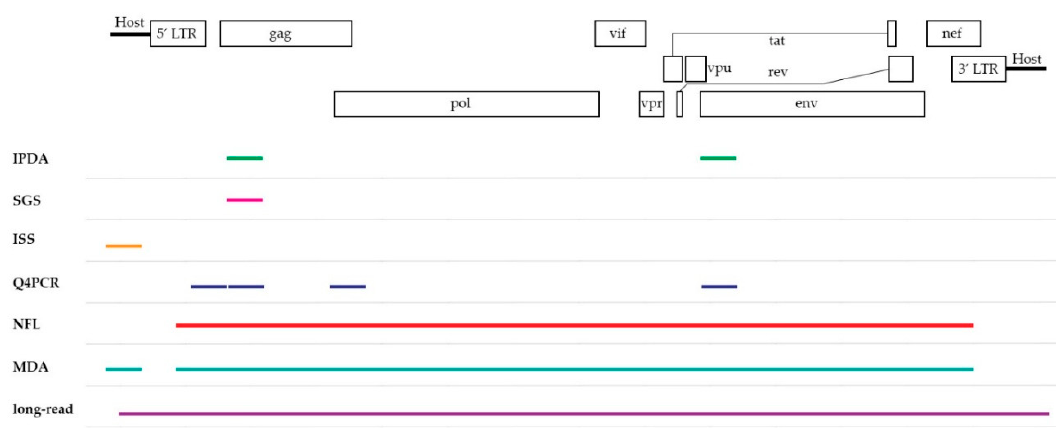
Figure 1. A schematic overview of the HIV-1 genome displaying the coverage of each assay discussed in this review. Note that the subgenomic coverage of SGS will depend on the target region of interest. IPDA = intact proviral DNA assay, SGS = single-genome/proviral sequencing, ISS = integration site sequencing, Q4PCR = quadruplex qPCR, NFL = near full-length sequencing, MDA = multiple-displacement amplification-based technologies, long-read = pooled CRISPR inverse PCR sequencing.